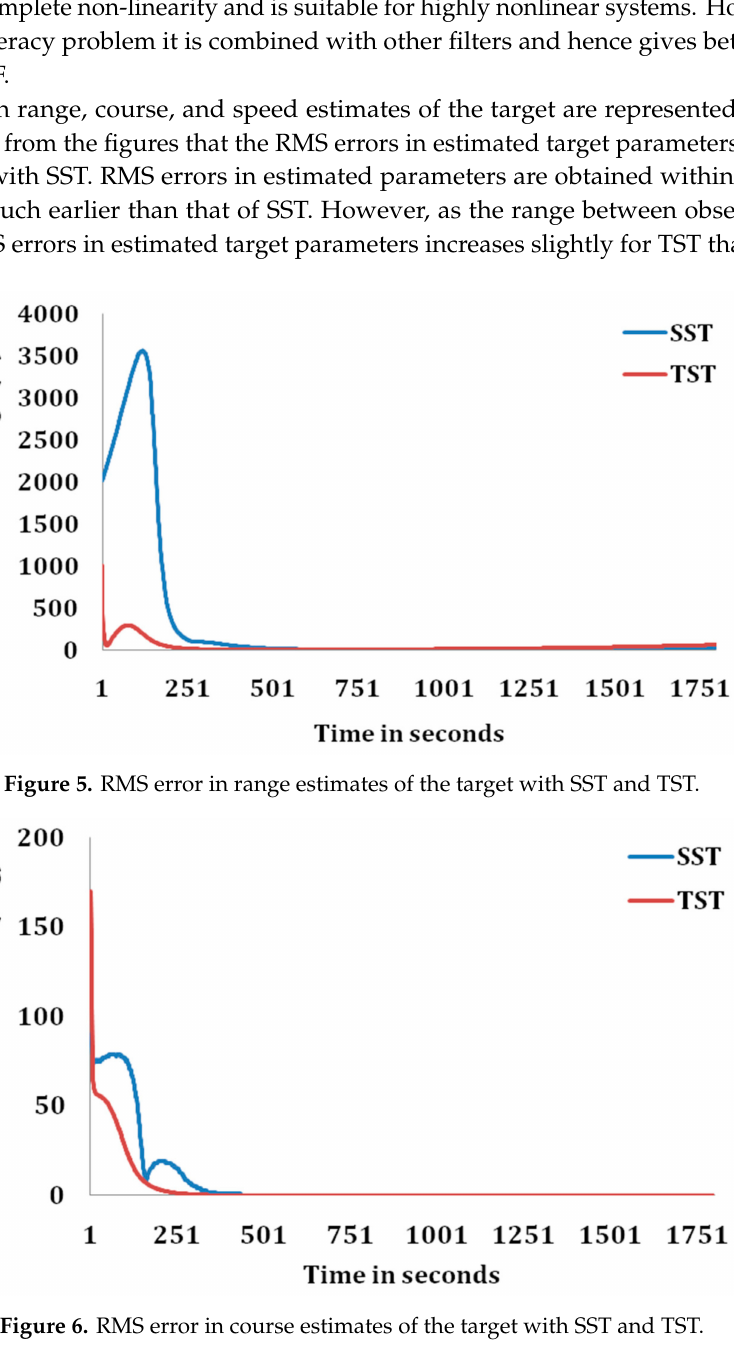
Figure 6. RMS error in course estimates of the target with SST and